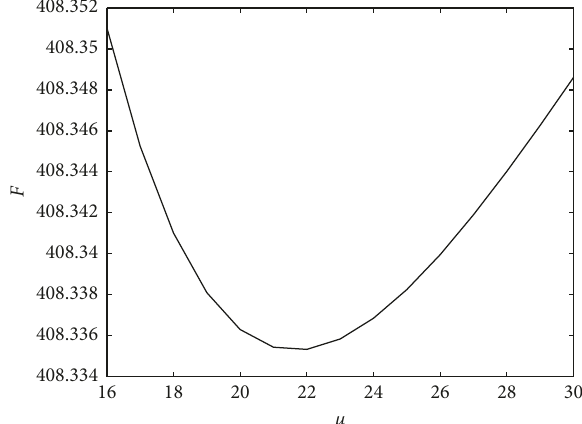
Figure 7: The effect of service rate μ on the cost function F .